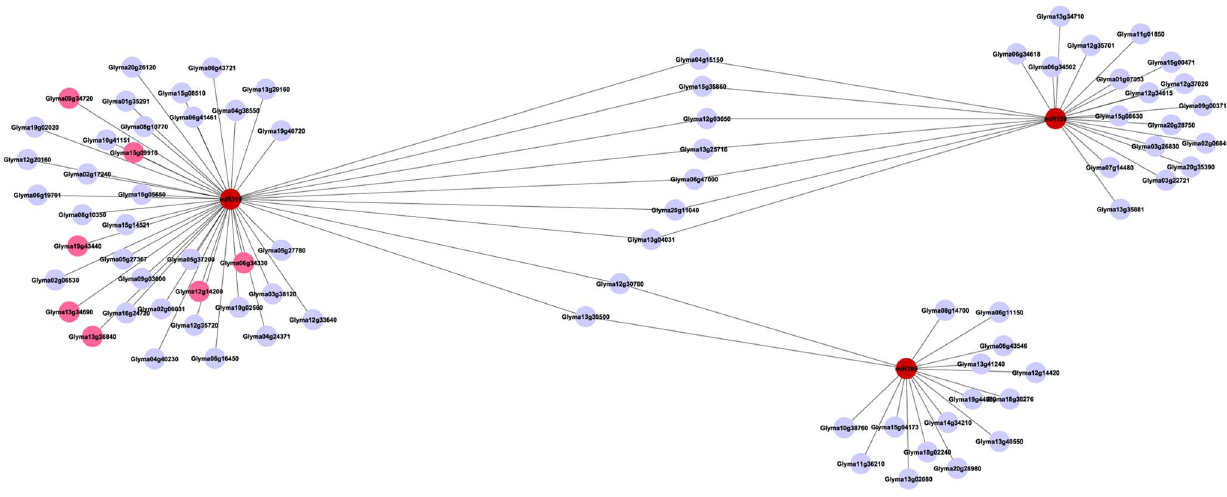
Figure 7. Interactions of miR395, 319 and 159 with Their Target Genes. Interactions of miR395, 319 and 159 (red circles) with their target genes (light blue circles and pink circles) are shown. Two targets are commonly regulated by miR319 and miR395 while seven targets are commonly regulated by miR319 and miR159. doi:10.1371/journal.pone.0086153.g007 gene regulatory networks. One-to-one, one-to-many, many-to-one network system composed of interaction modules of variable size and many-to-many interactions of miRNA-target gene/pathways in soybean cotyledons. The topology of the miRNA-gene and were identified, which could further form a complex regulatory miRNA-pathway networks provides a comprehensive view into